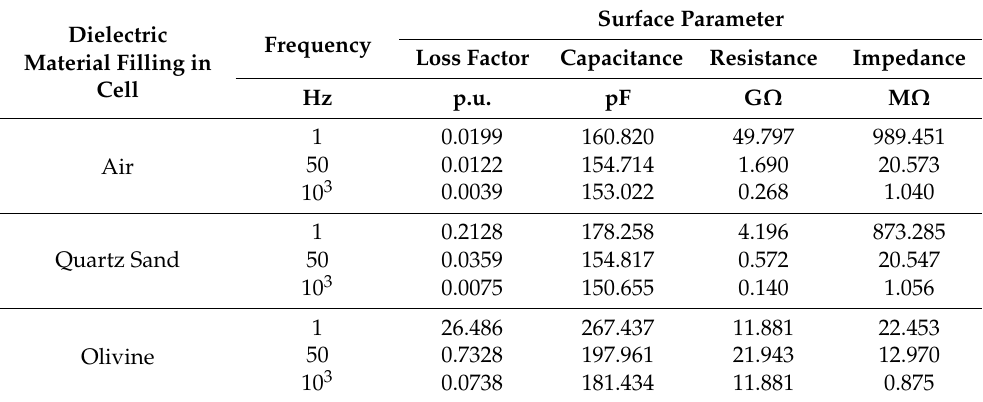
The procedure of the dielectric response analysis involved either analysing the loss factor, resistance, or capacitance properties individually. Alternately, the impedance of the materials and/or the test objects measured altogether characterises the collective re- sponse of the DBD materials initiated by the material conductance and capacitive reactance, respectively. In other words, the response of the test materials or test objects, which are physically realizable during a real-time measurement, can be recorded and analysed, while the resistance and capacitance parameters measured are components of the total response measured. Therefore, the measured impedance provides a complete overview of the ma- terial’s characteristics over a wide frequency range, hence being sufficient to understand the overall diagnostic condition and/or status of the materials or test objects under in- vestigation. Figure 5d shows the apparent surface impedance measured from the chosen DBD materials over a wide frequency range. The collective behaviour of surface resistance (conductivity) and surface capacitance (charges stored) can be viewed by the impedance shown in Figure 5d. As observed from Figure 5a–c, the olivine emerged with a lower impedance at lower frequencies, indicating more conductivity than the geometry of the test cell (air) and the quartz sand material. As the frequency increased, the total response of the olivine seemed to be in line with the air and quartz sand material. This reconfirms that